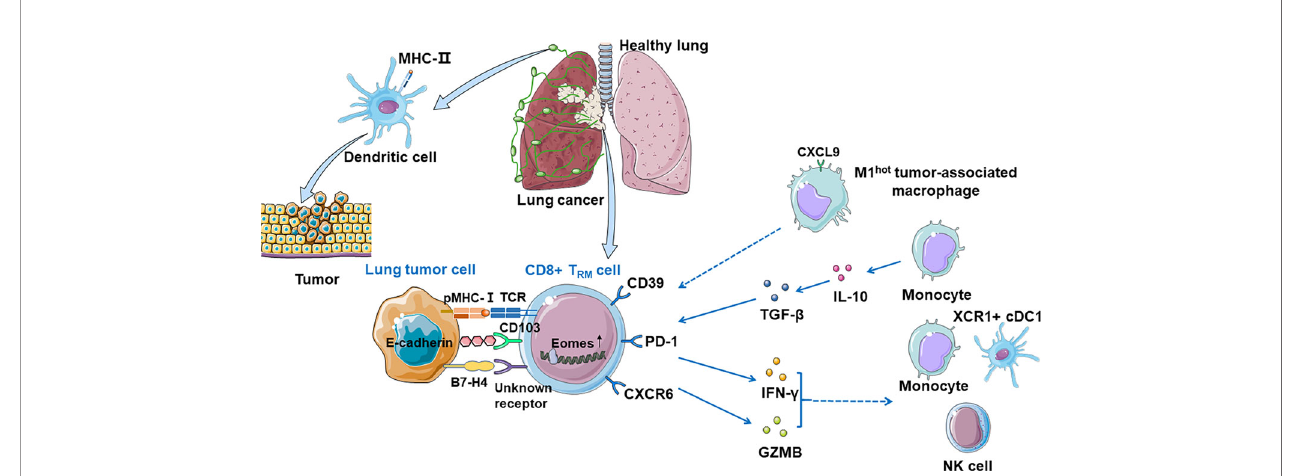
FIGURE 2 | CD8+ T RM cells in anti-tumor immunity. Dendritic cells present tumor antigens in the tumor-draining lymph nodes and then migrate to the tumor where they recognize their cognate antigens and expand, priming CD8+ T cells signi fi cantly. Tumor-associated CD8+ T RM cells can be identi fi ed by CD39 and CD103, and CD103 promotes immunologic synapse by binding to E-cadherin on tumor cells. T RM cells which express PD-1 are expanded and enriched for transcripts linked to cell proliferation and cytotoxicity. CXCR6 is expressed on the surface of T RM cells when exposed to tumor antigens, transferring T RM cells from pulmonary interstitium to tumor microenvironment, and maintaining the T RM cell pool. M1 hot TAMs recruit T RM cells via CXCL9 expression and sustain them by making more essential fatty acids on which T RM cells depend. Monocytes prime T RM cells via IL-10-mediated TGF- b release which increases the number of local T RM cells. CD8+ CD103+ T RM cells can also produce GZMB and IFN- g , which recruits monocytes, NK cells, and XCR1+ cDC1 to the tumor site. B7-H4 on tumor cells might upregulate Eomes in T cells, which may cause growing TILs